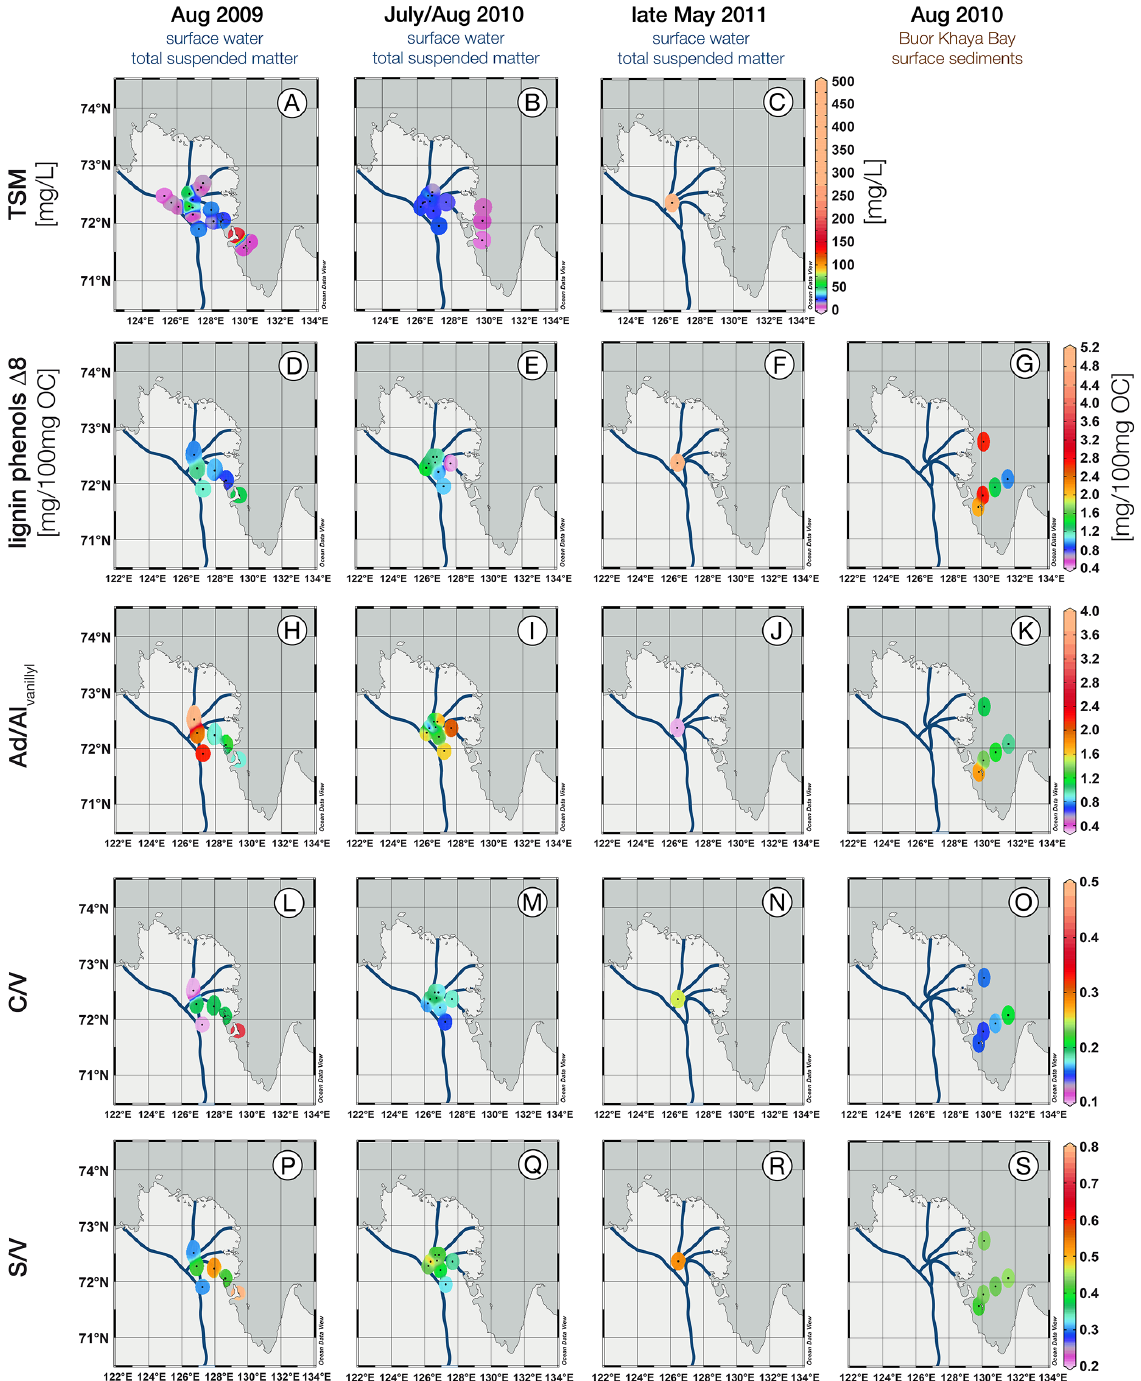
Figure 3. Spatial distribution of carbon-normalized lignin concentrations ( (cid:51) 8) and lignin parameters of Lena Delta total suspended matter (TSM) and Buor Khaya Bay surface sediments. Ad / Al vanillyl : acid to aldehyde ratio of the vanillyl phenols; C / V: ratio of cinnamyl to vanillyl phenols; and S / V: ratio of syringyl to vanillyl